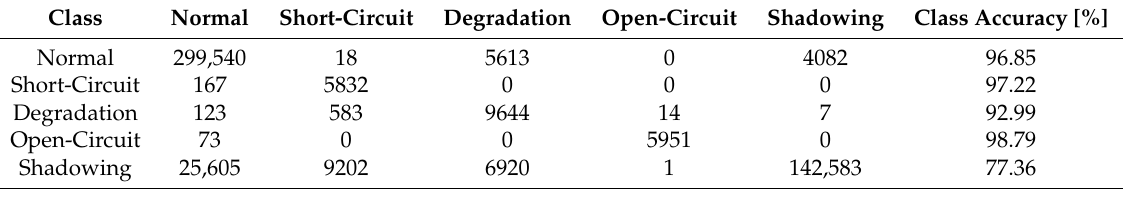
Table 13. Confusion Matrix for Combined Detection and Classification